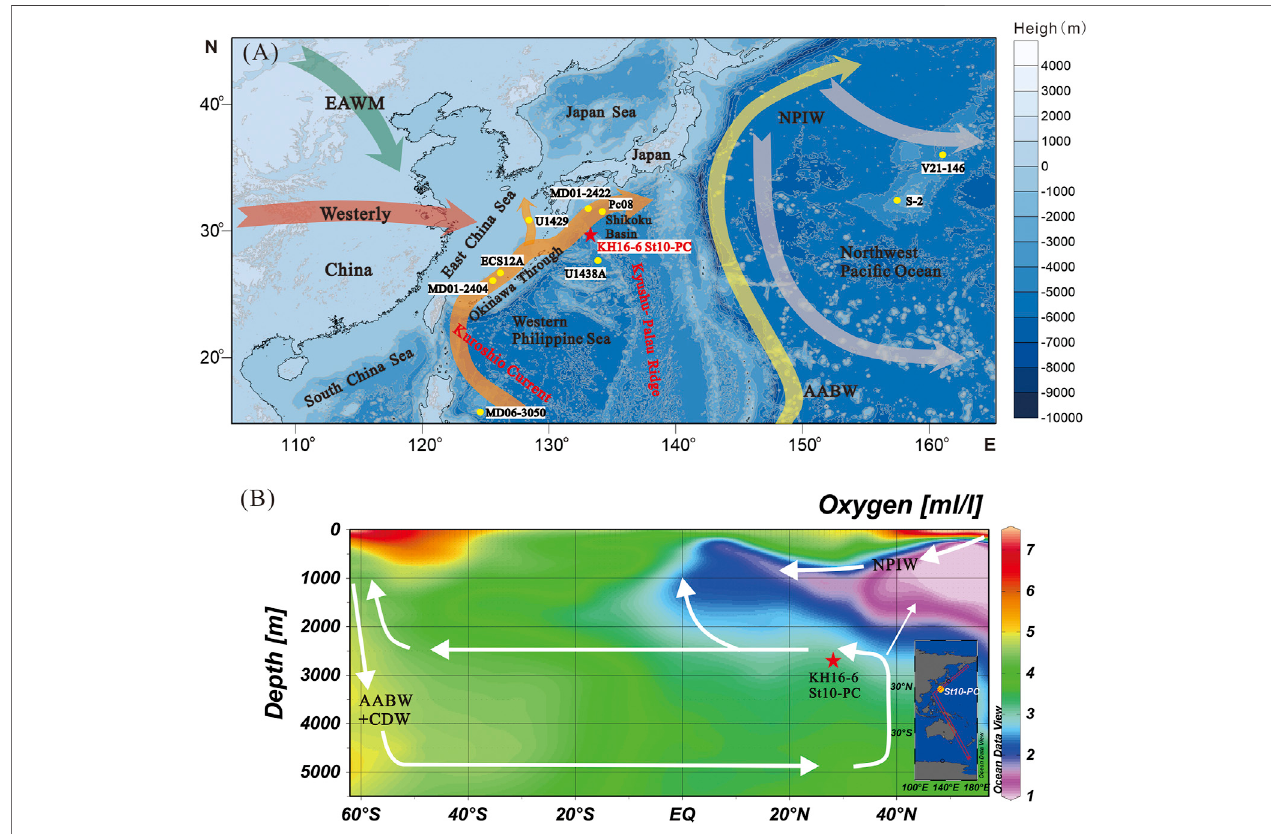
FIGURE 1 | The core location and regional oceanographic settings in the study area. (A) Red pentagram star: the sediment core KH-16-6 St10-PC in this paper; yellow dots: typical reference cores (MD06-3050 from Sun et al., 2011; MD01-2404 from Zou et al., 2021; ECS12A from Shao et al., 2016; U1438A from Zhou et al., 2016; U1429 from Vats et al., 2020; MD01-2422 and PC08 from Ikehara et al., 2009; S-2 from Amo and Minagawa, 2003; V21-146 from Hovan et al., 1989); red and green arrows: westerly and East Asian winter monsoon (EAWM) respectively (Wan et al., 2012); orange arrow: Kuroshio Current (KC) (Gallagher et al., 2015); gray arrow: North Paci fi c Intermediate Water (NPIW) (Rippert et al., 2017); yellow arrow: Antarctic Bottom Water (AABW) (Kender et al., 2018). (B) Meridional section of present-day oxygen concentrations from the North Paci fi c to the Southern Ocean (http://www.nodc.noaa.gov/OC5/WOA09/woa09data.html) and major modern mid- depth to deep-water currents (white arrows) (Rippert et al., 2017): AABW: Antarctic Bottom Water, CDW: Circumpolar Deep Water; red line in right map denotes the transect.